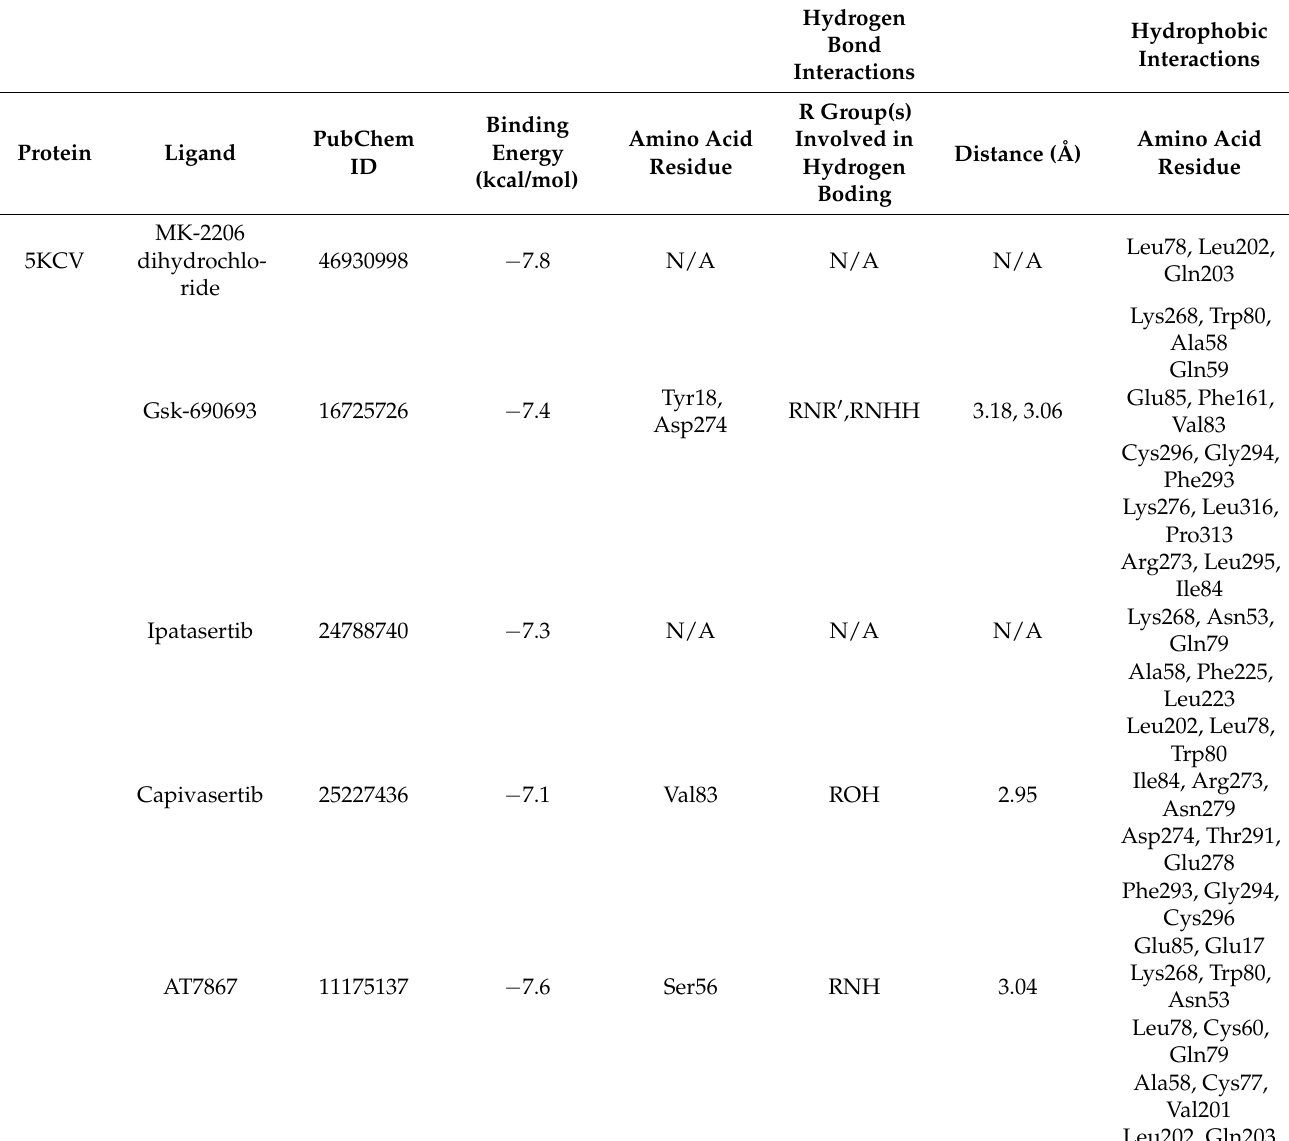
Table 9. Binding energy of the positive controls on Akt1 (PDB ID: 5KCV).